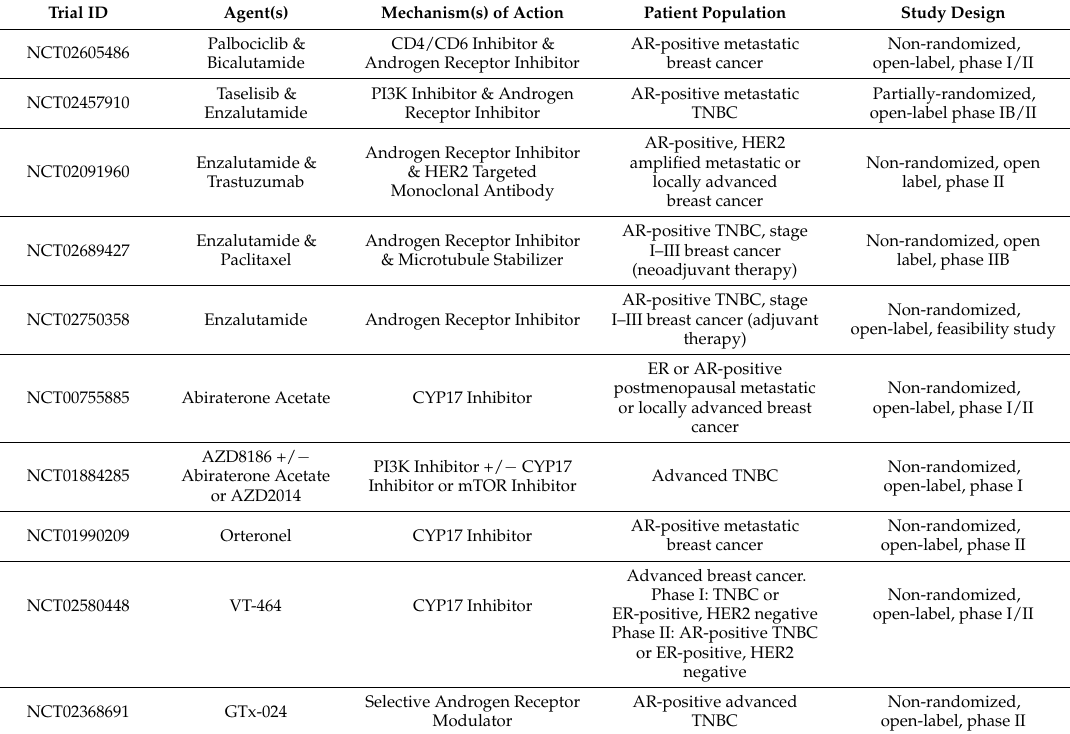
Table 1. Ongoing breast cancer clinical